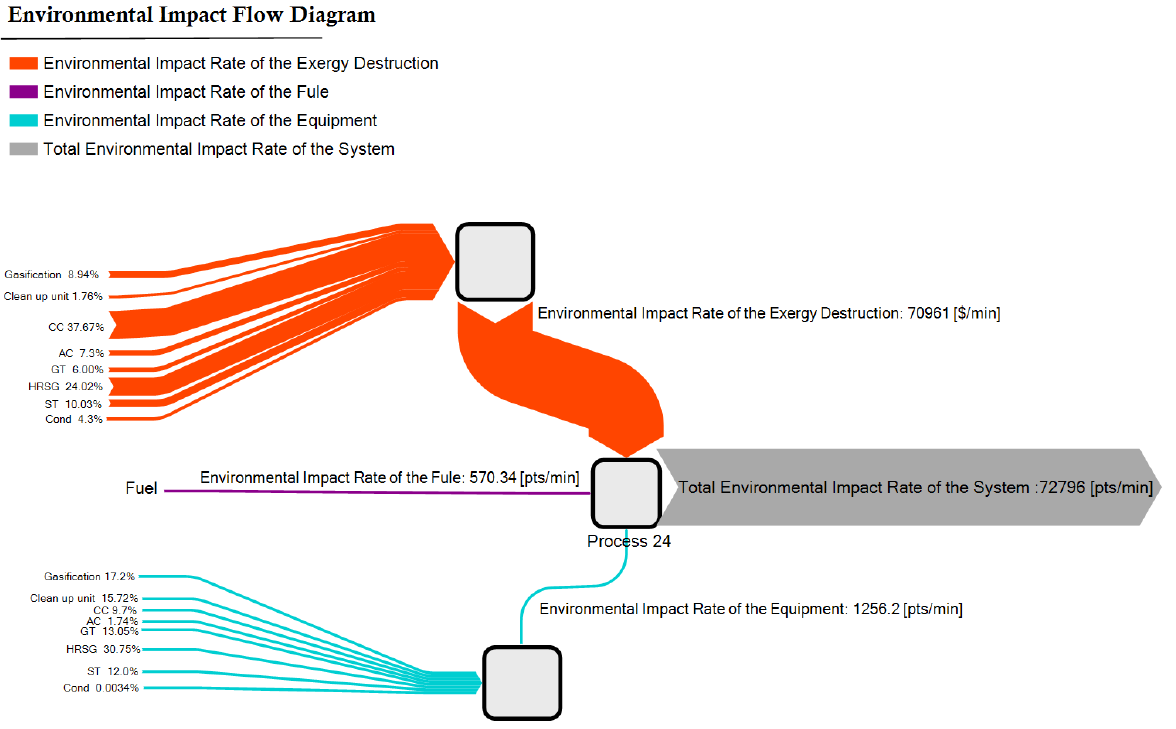
Figure 3. Cost flow diagram of the proposed integrated solar-gasification cycle (ISGC) system. AC: Air compressor; Cond: Condenser; CC: Combustion chamber; GT: Gas turbine; HRSG: heat recovery steam generator; ST: steam turbine.